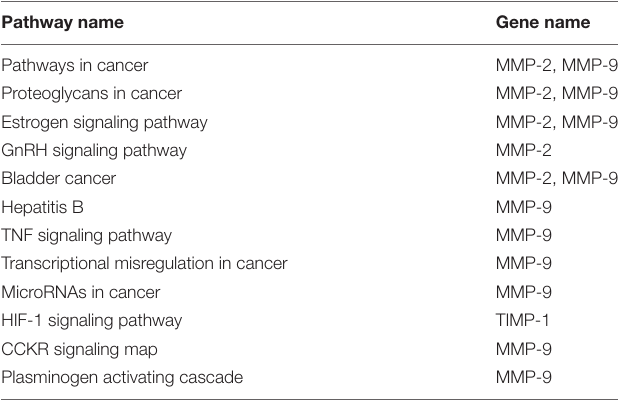
TABLE 2 | Pathway including MMP-2, MMP-9, and TIMP-1